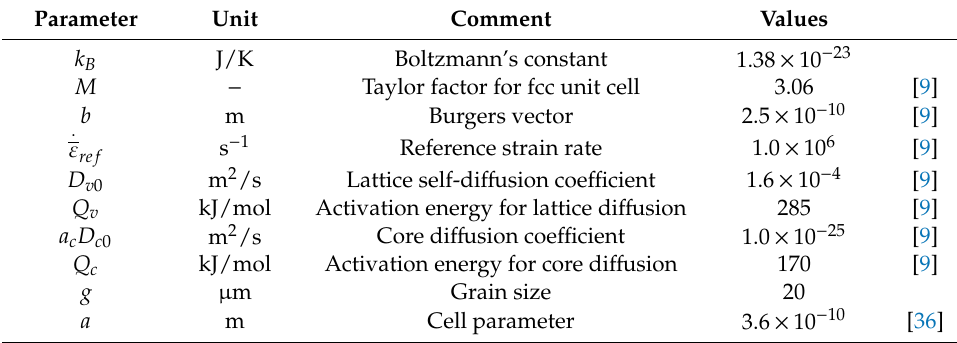
Table 3. Known or assumed parameters used in the flow stress model both for alloy 625 and alloy